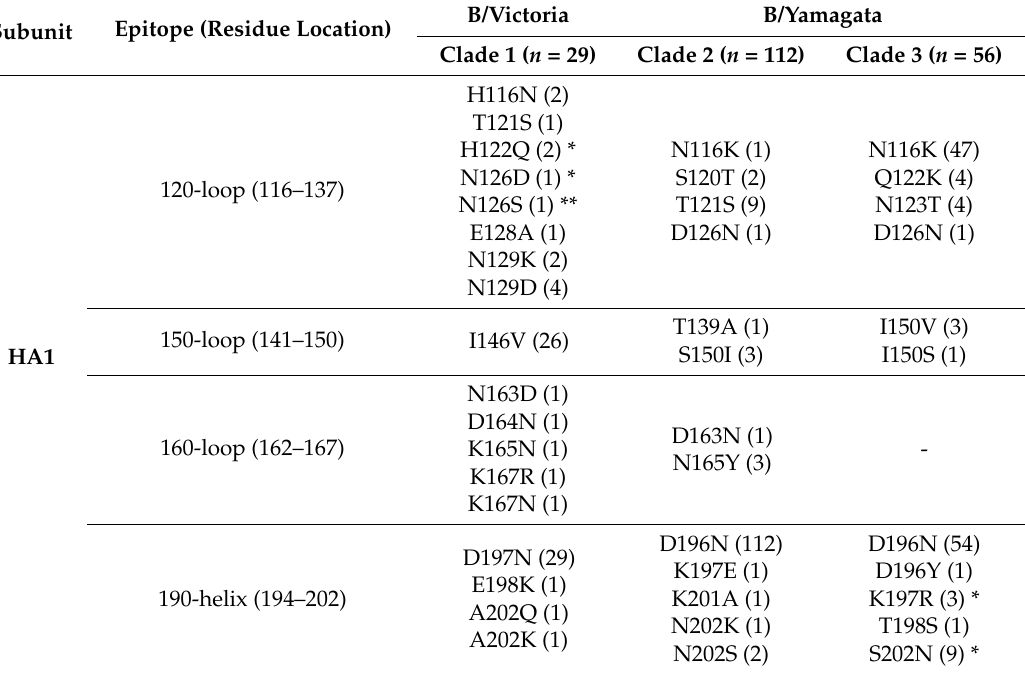
Table 1. Amino-acid substitutions found on the hemagglutinin (HA) protein of influenza B viruses detected in Italy during the period 2010–2015, according to B